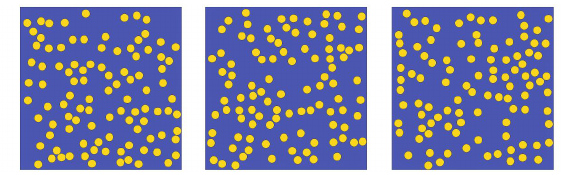
Figure 5: Three different random arrangements of fibers generated by the present algorithm with v f = 20% and n f = 100